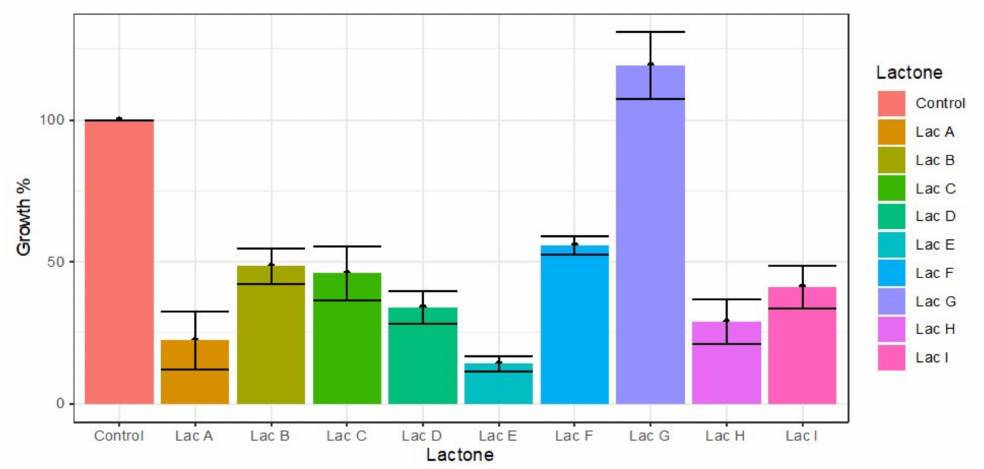
Figure 8. Effect of lactones on the cell proliferation of C. raciborskii: 3-oxodecanoyl ( A ), N- (3-oxododecanoyl)-L-homoserine lactone ( B ), N-hexanoyl ( C ), decanoyl ( D ), heptanoyl ( E ), N- dodecanoyl ( F ), N-octanoyl ( G ), N-(3- oxo-octanoyl ( H ), and N-butyryl-homoserine lactone ( I ). Except for lactone G, which had a slight inducing effect, the substances analyzed exhibited inhibitory effects on C. raciborskii cell proliferation, mainly lactones A and